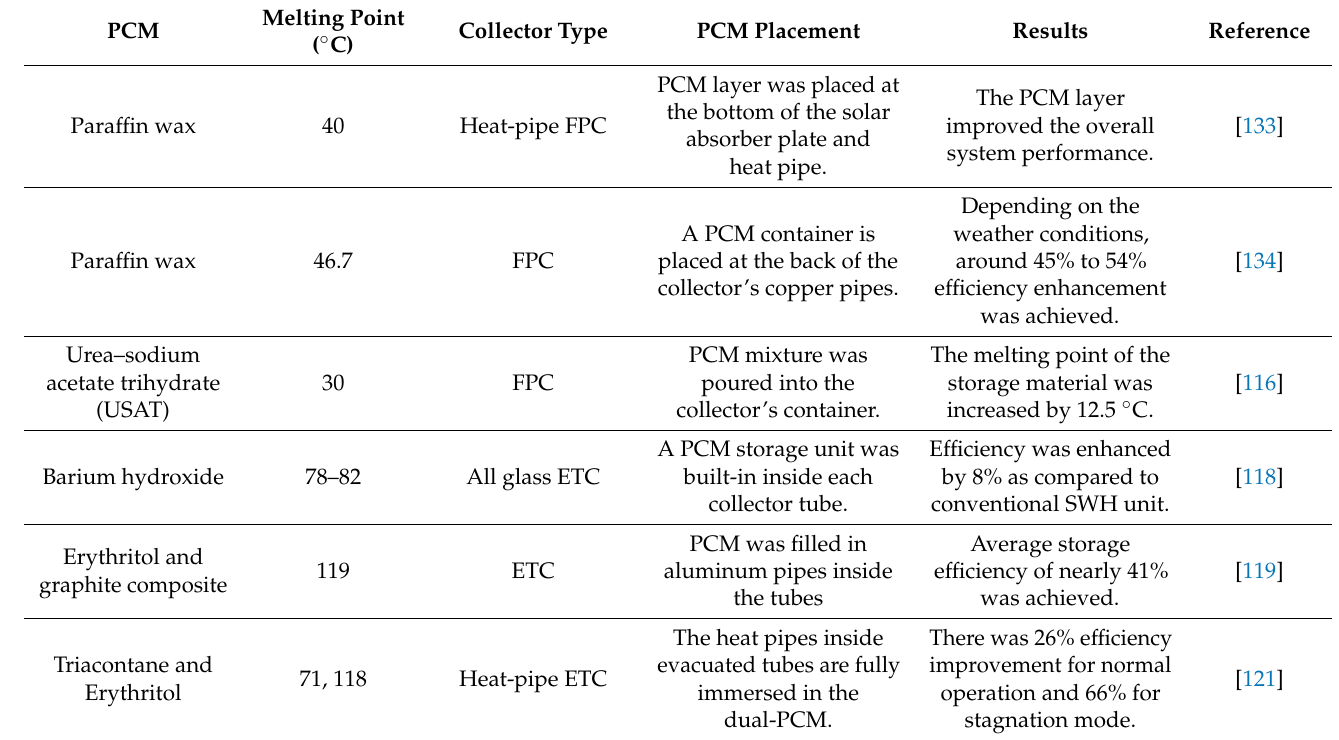
Table 6. A few studies on the integration of TES systems on solar